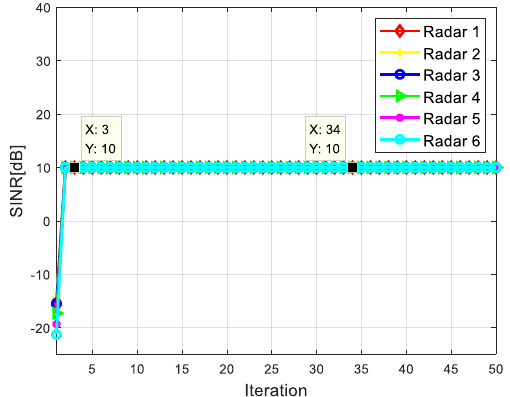
Figure 9. Radar SINR convergence performance.